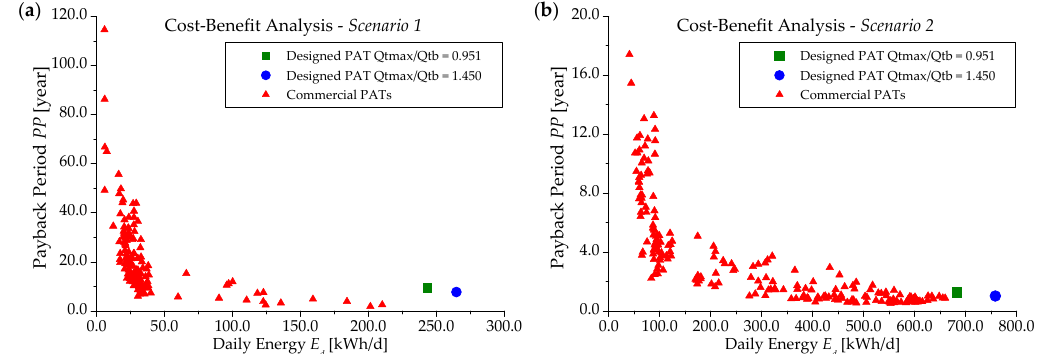
Figure 2. Cost-Benefit analysis for ( a ) Scenario 1 and ( b ) Scenario 2